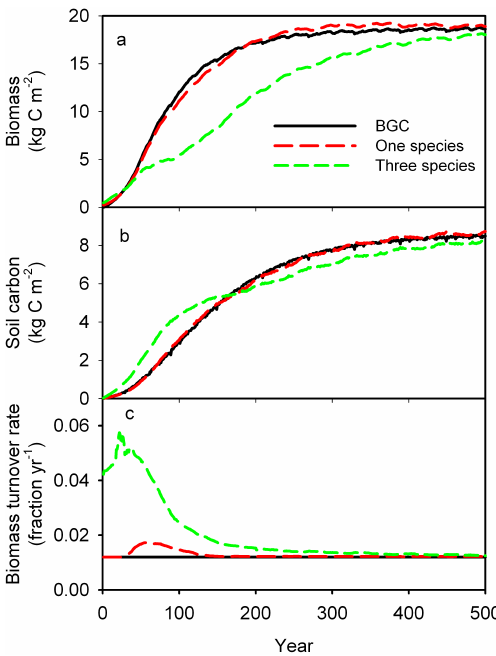
Figure 7. Simulated dynamics of biomass (a) , soil carbon (b) , and biomass turnover rate (c) in LM3-PPA and in a standard biogeo- chemical cycle (BGC) model that does not represent individual- level processes. LM3-PPA was simulated with either one species ( Acer saccharum ) or all three species in Table 1 and Fig. 4a. The standard BGC model is summarized in Fig.